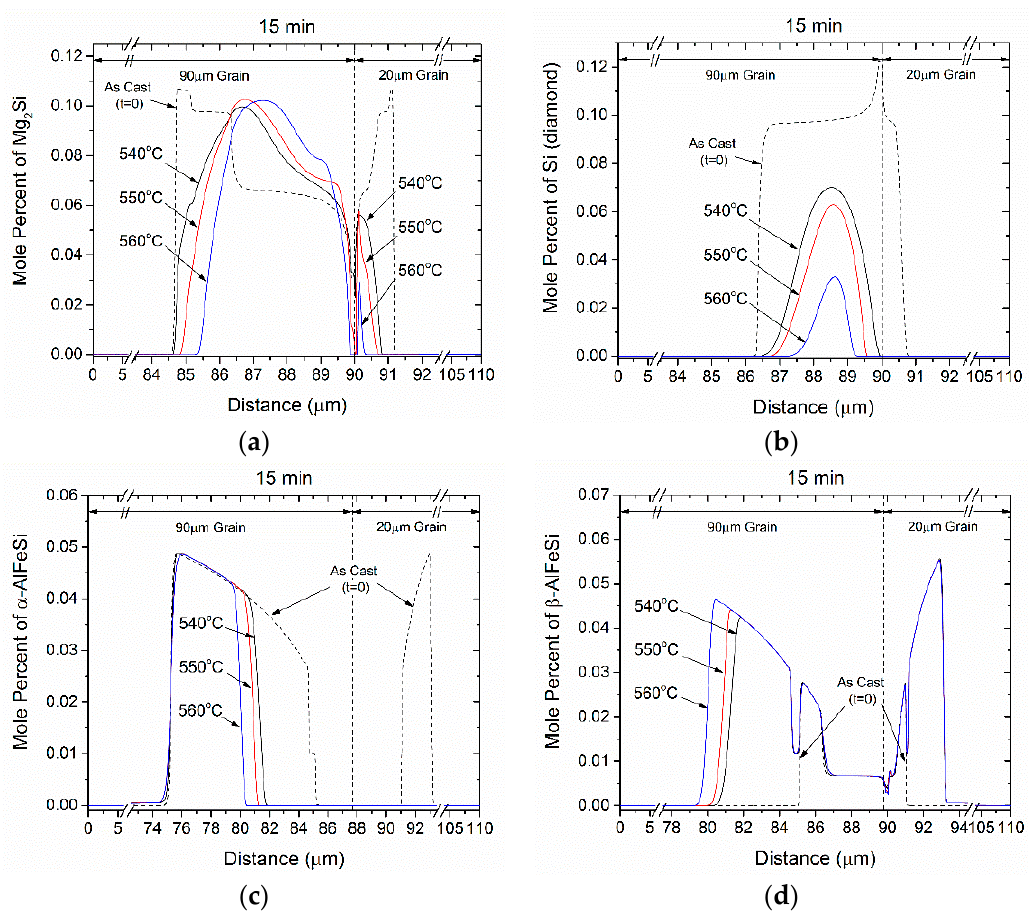
Figure 8. Spatial distribution of the mole percent of ( a ) Mg 2 Si, ( b ) Si (diamond), ( c ) α -AlFeSi, and ( d ) β -AlFeSi after homogenization of 6082 alloy for 15 min at various temperatures (540, 550 and 560 °C).